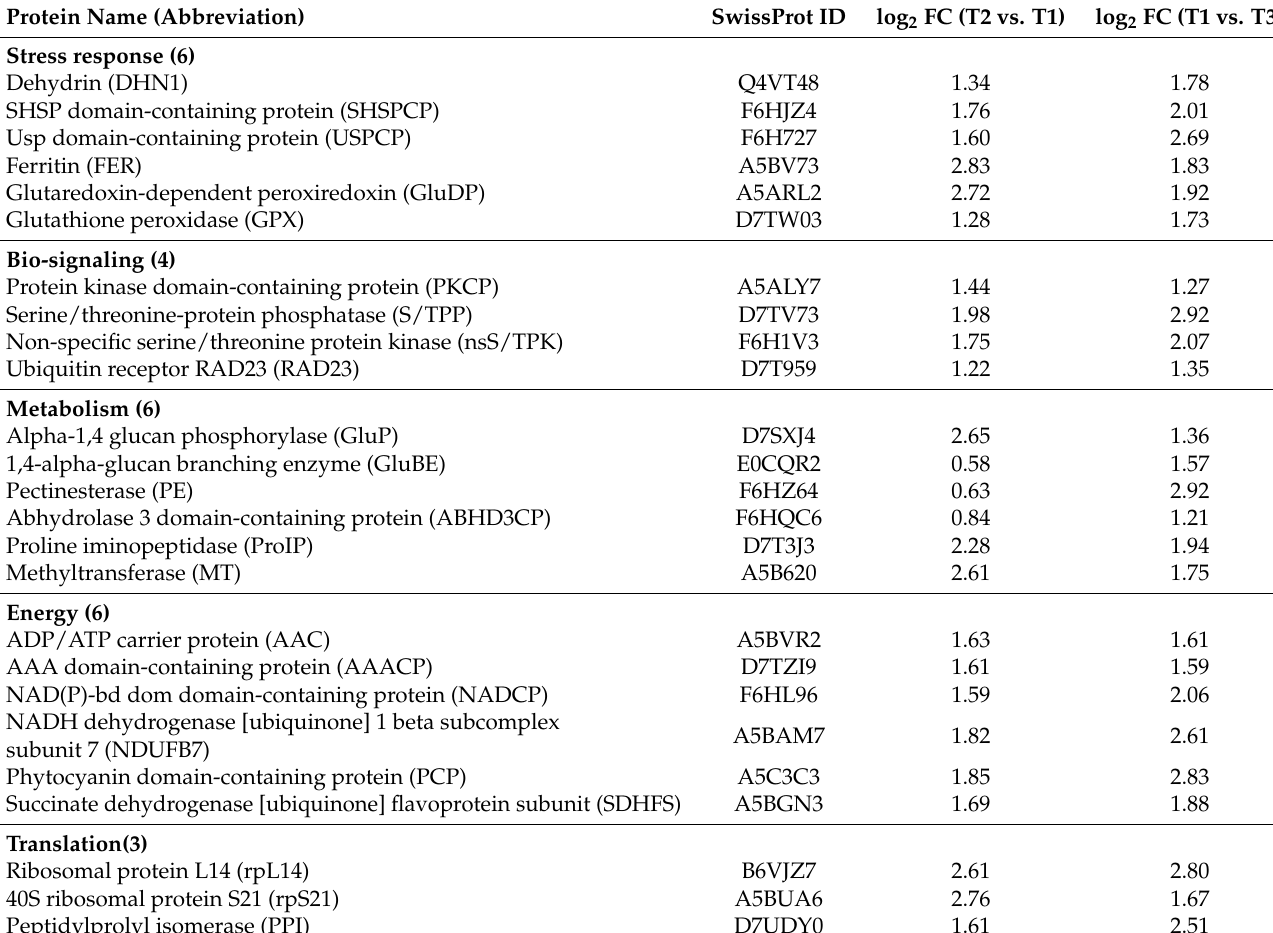
Figure 5. Distribution and classification of DEPs in roots of V. riparia × V. labrusca and Cabernet Sauvignon with different treatments. Table 1. The 25 DEPs identified in V. riparia × V. labrusca and Cabernet Sauvignon with different treatments.